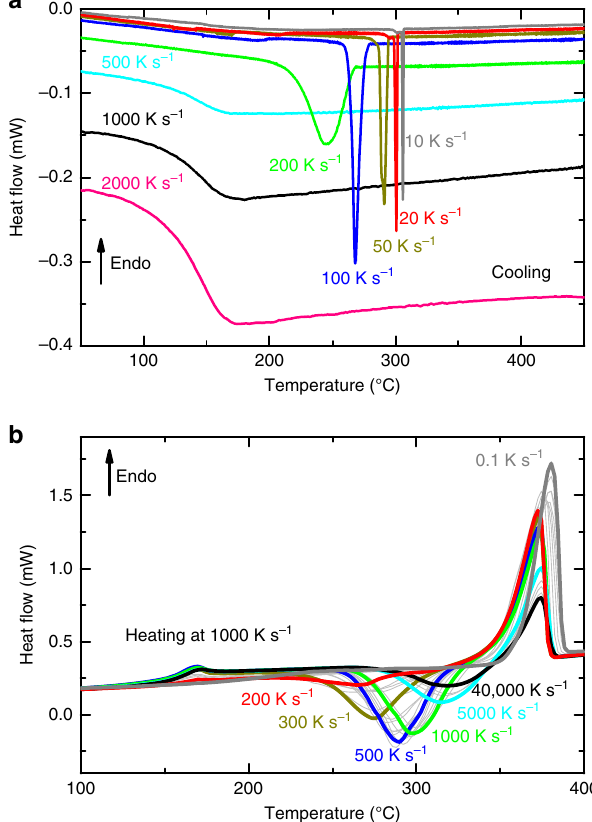
Fig. 1 Phase transformations upon cooling and heating. a Selected cooling curves from the melt measured at various rates. Crystallization occurs at slow cooling up to approximately 200 K s − 1 . At faster cooling the sample forms a glass. b Heating curves measured at 1000 K s − 1 after cooling at various rates between 0.1 K s − 1 and 40,000 K s − 1 . The previous cooling rates are indicated only for the thickly drawn curves, while curves measured for other cooling rates are thin and